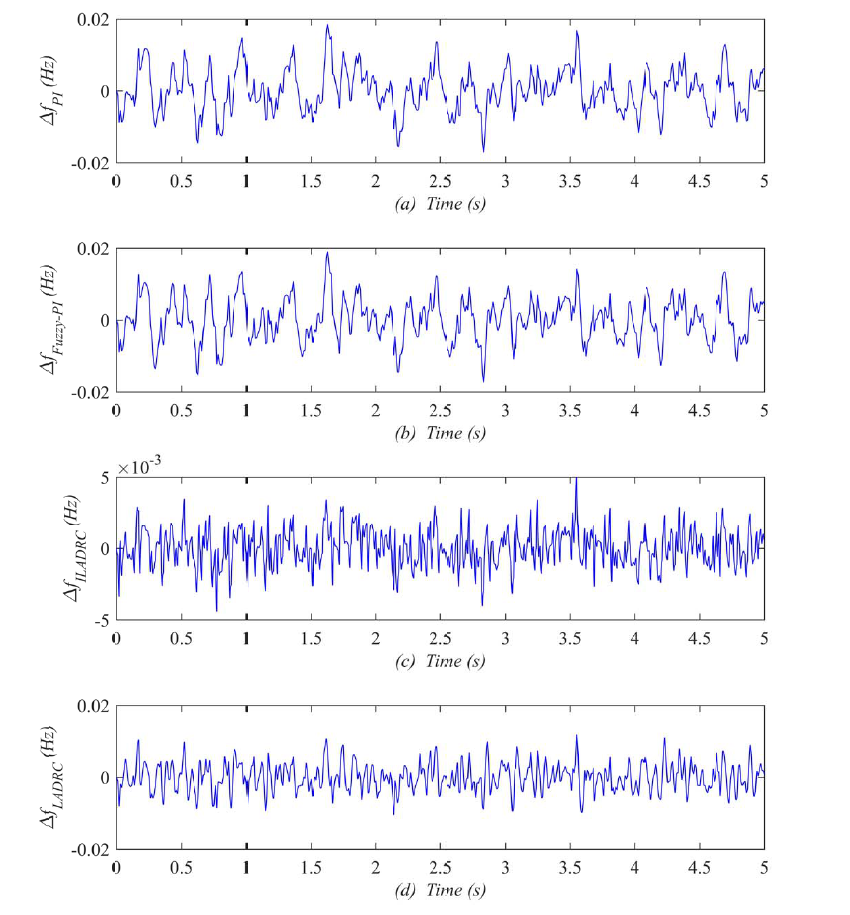
Figure 19. Transient response of system frequency deviation under stochastic power of wind turbine generator and stochastic load demand. ( a ) Frequency deviation with PI controller; ( b ) Frequency deviation with Fuzzy-PI controller; ( c ) Frequency deviation with ILADRC controller; ( d ) Frequency deviation with LADRC